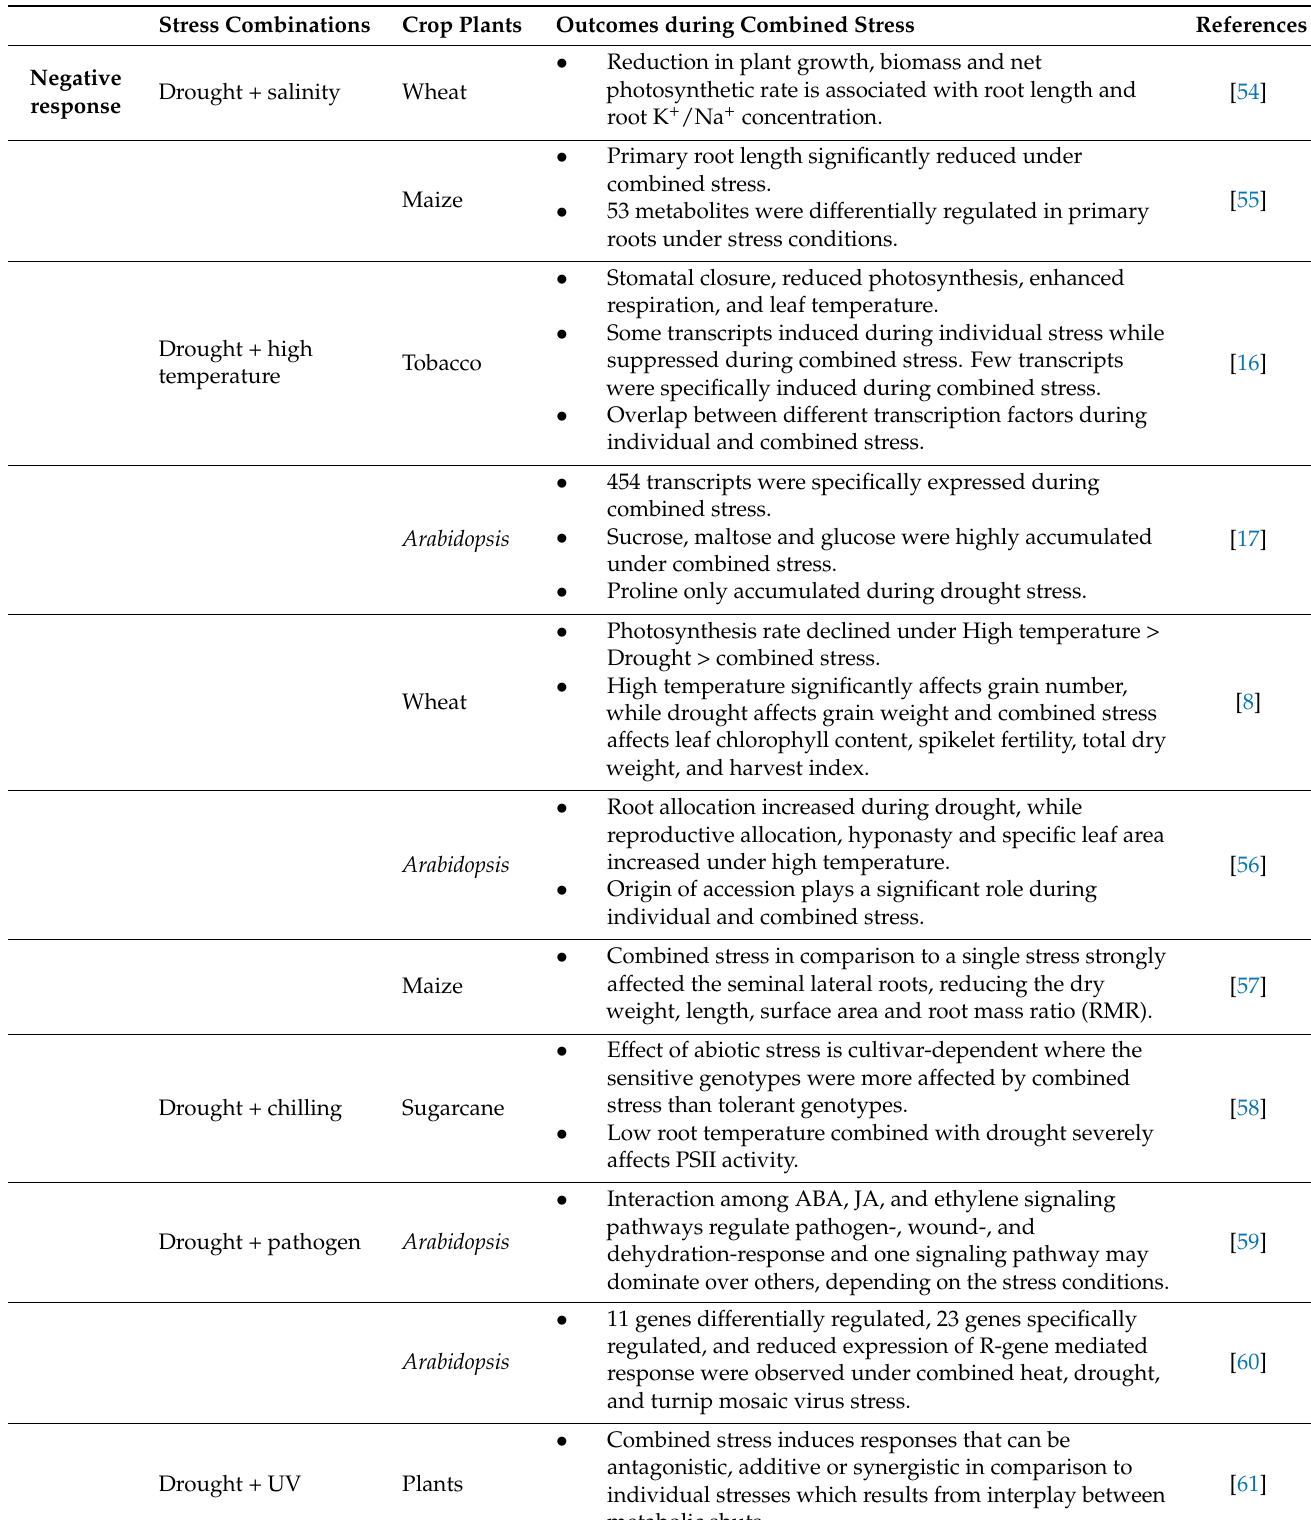
Table 2. Representative examples showing the specific interactions among various stress combinations on diverse plants. Stress